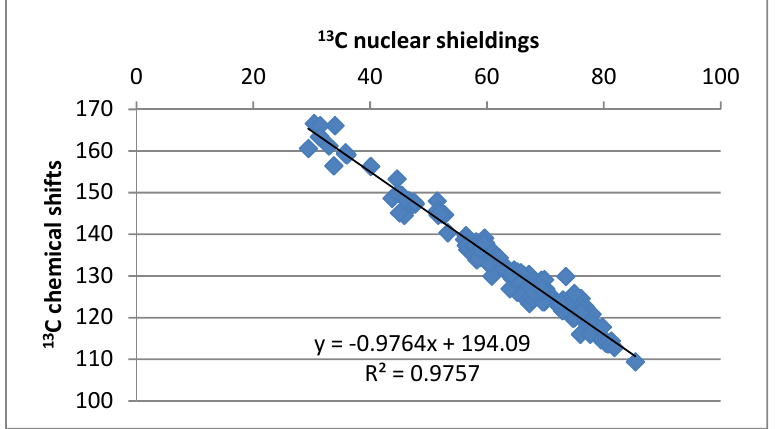
y = ‐ 0.9764x + 194.09 R² =